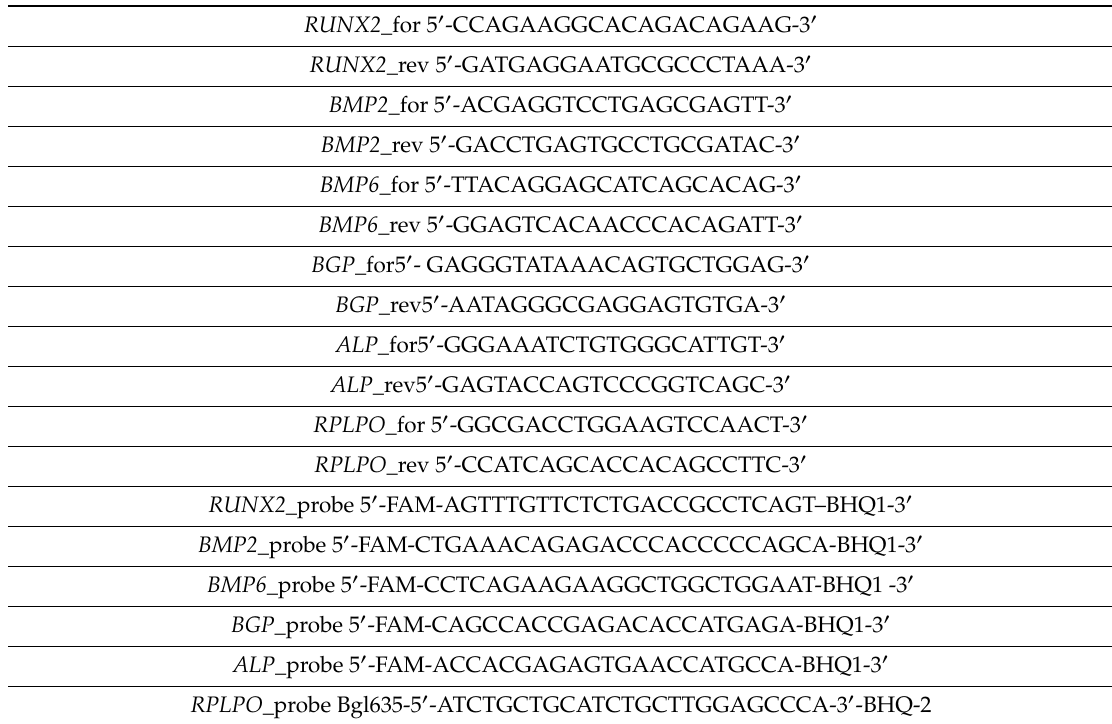
Table 5. Sequences of oligonucleotide primers used in the